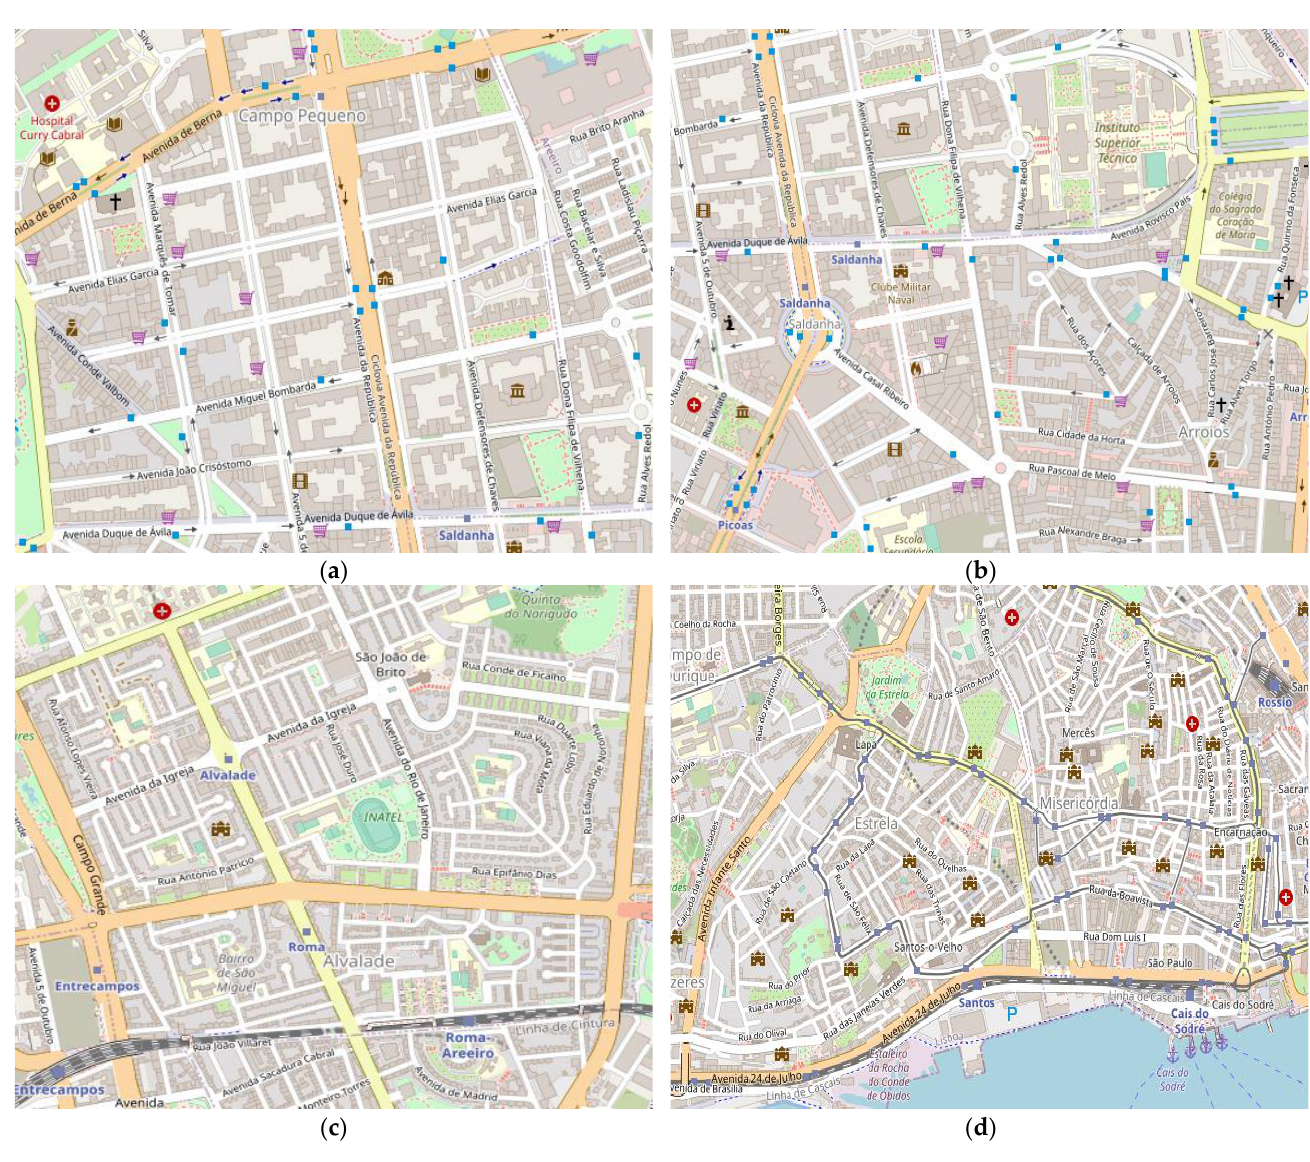
Figure 2. Selected areas in Lisbon. ( a ) Campo Pequeno region; ( b ) Saldanha region; ( c ) Alvalade region; and ( d ) Cais do Sodré region.